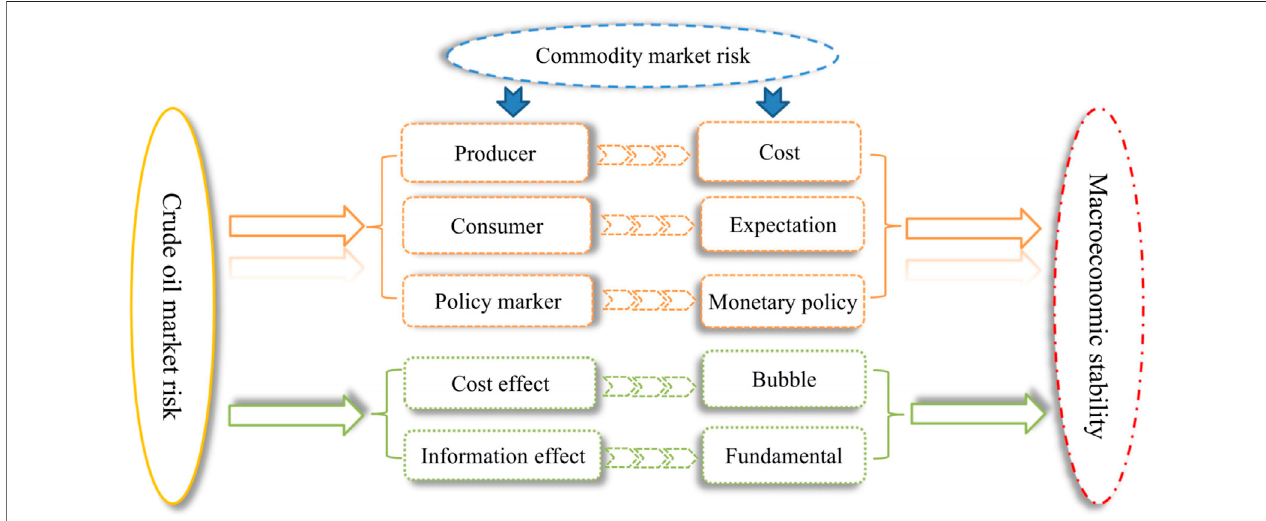
FIGURE 1 | Formation mechanism of the channel effect of commodity market